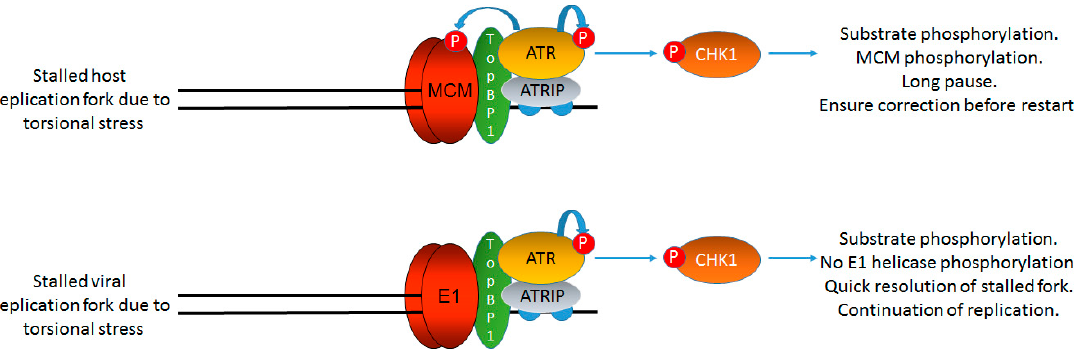
Figure 4. HPV replication is not arrested by DDR signaling. The failure of DDR signaling to arrest E1–E2 mediated DNA replication is essential for the viral life cycle as an active DDR is required for viral replication. However, host cell replication is arrested in the presence of DDR signaling via the phosphorylation of MCM proteins by ATR (and ATM). This uncouples the MCM helicase from DNA polymerases allowing for replication arrest, repair, and restart (top panel). The virus does not have this luxury as it must replicate in the presence of a DDR (bottom panel); therefore, HPV replication has an inherent instability as replication in the presence of external DNA damaging agents is mutagenic as viral replication is not arrested. This mutagenesis would provide substrates for viral genome integration into that of the host, a hallmark of cervical cancer. The DDR signaling generated by E1–E2 replication must be controlled locally to avoid viral arrest of host cell replication via MCM-polymerase uncoupling; such an arrest would be fatal for the viral life cycle. The black lines represent DNA strands. The blue “circular” line represents phosphorylation events.